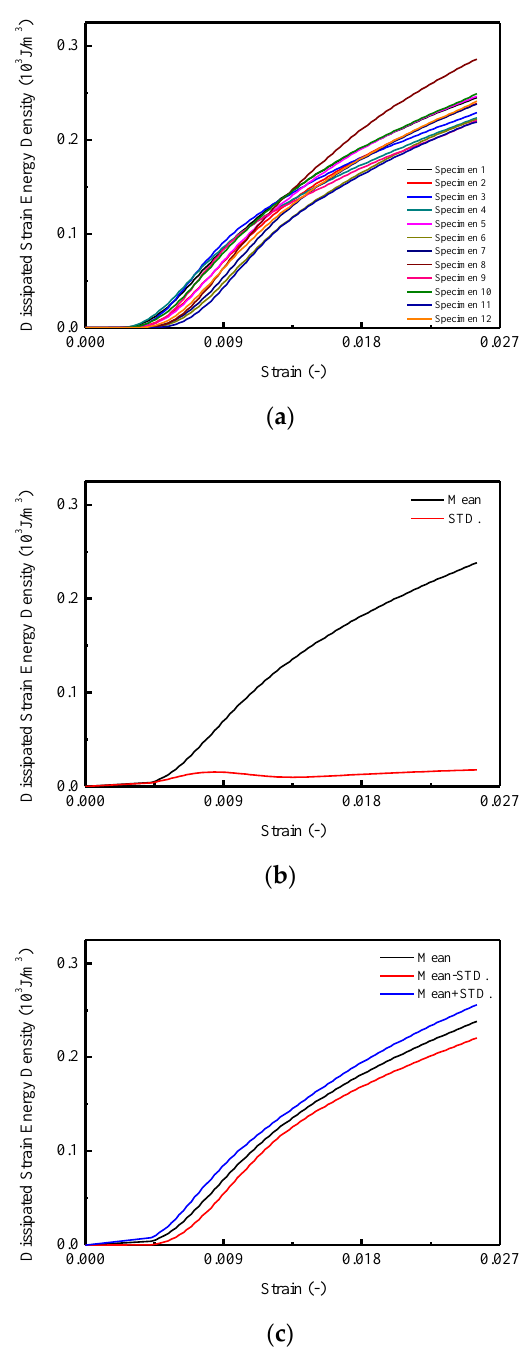
Figure 9. Dissipated strain energy of CA mortar specimens: ( a ) Dissipated strain energy of specimens; ( b ) Mean and STD. for dissipated strain energy; ( c ) Mean ± STD. for dissipated strain energy.